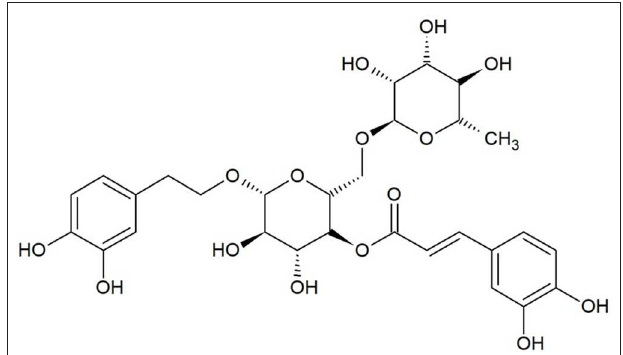
FIGURE 2 | Forsythoside A (C 29 H36O 15